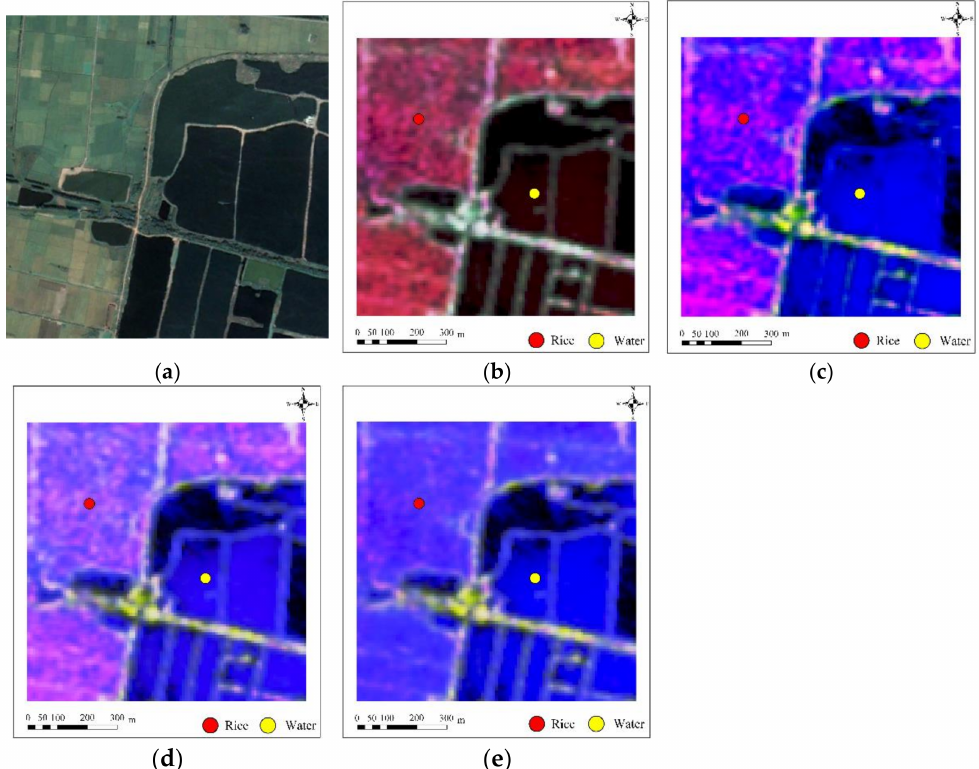
Figure 8. Examples of rice in the optical image and the false color composite images with different combinations of statistical parameters. ( a ) The Google image of rice and water area; ( b ) R: maximum G: minimum B: average; ( c ) R: maximum G: minimum B: variance; ( d ) R: maximum G: average B: variance; ( e ) R: average G: minimum B: variance.